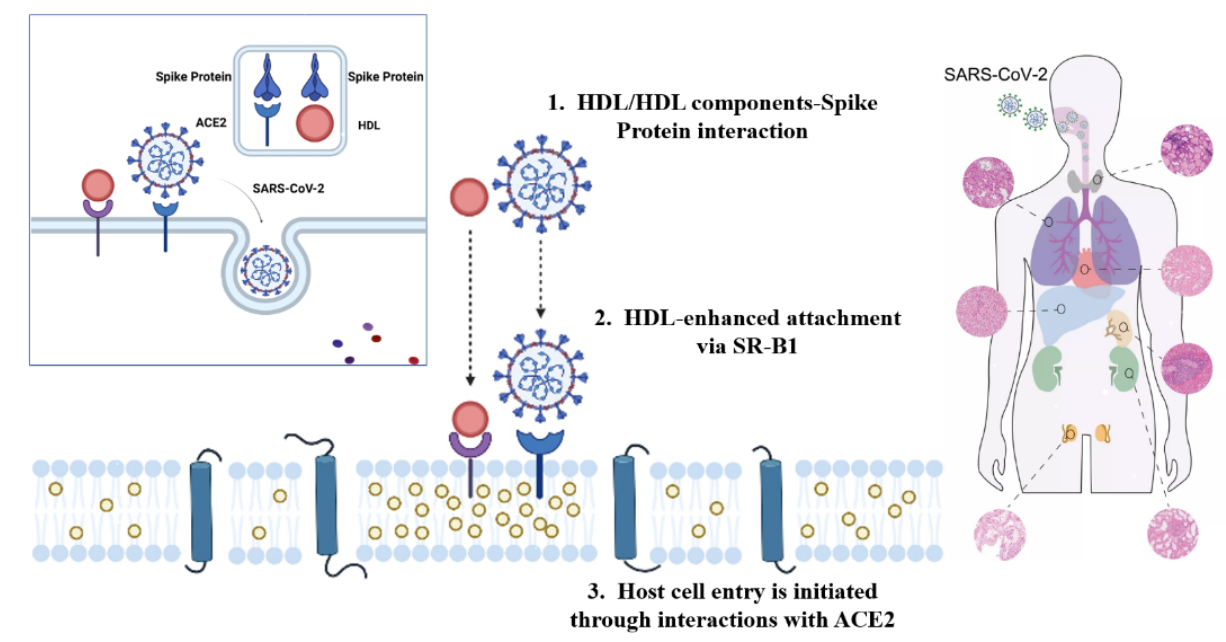
Figure 1. COVID-19 pathology mechanism.